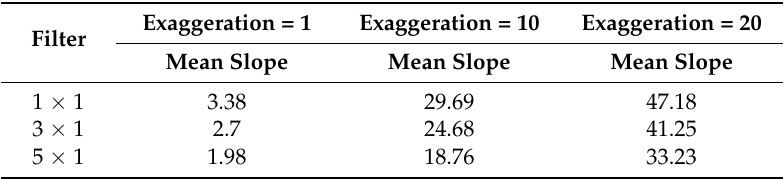
Table 2. Mean slopes of the